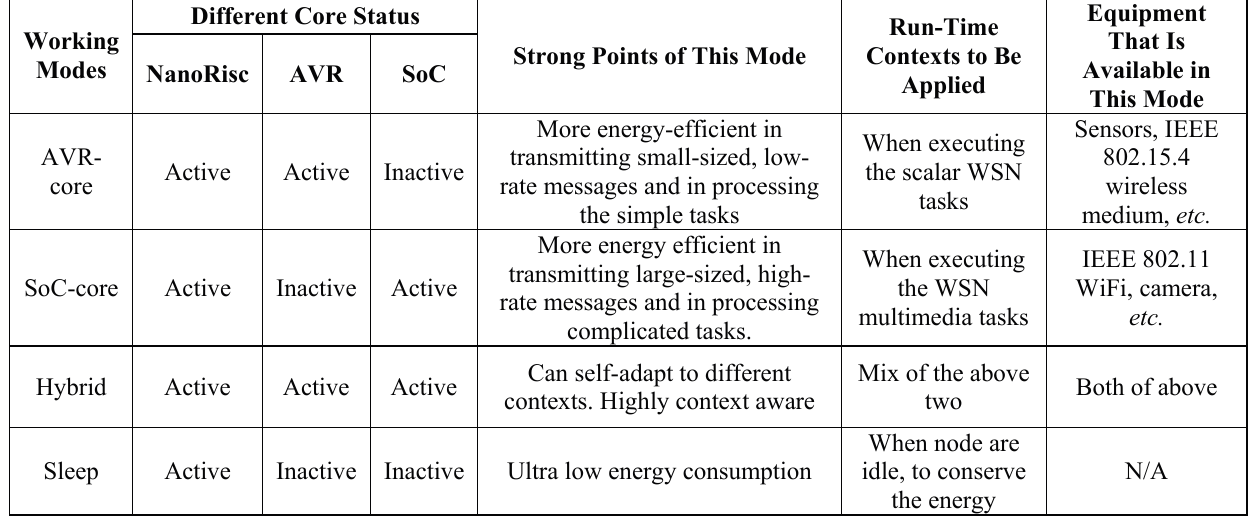
Table 11. Different working modes of MiLive.